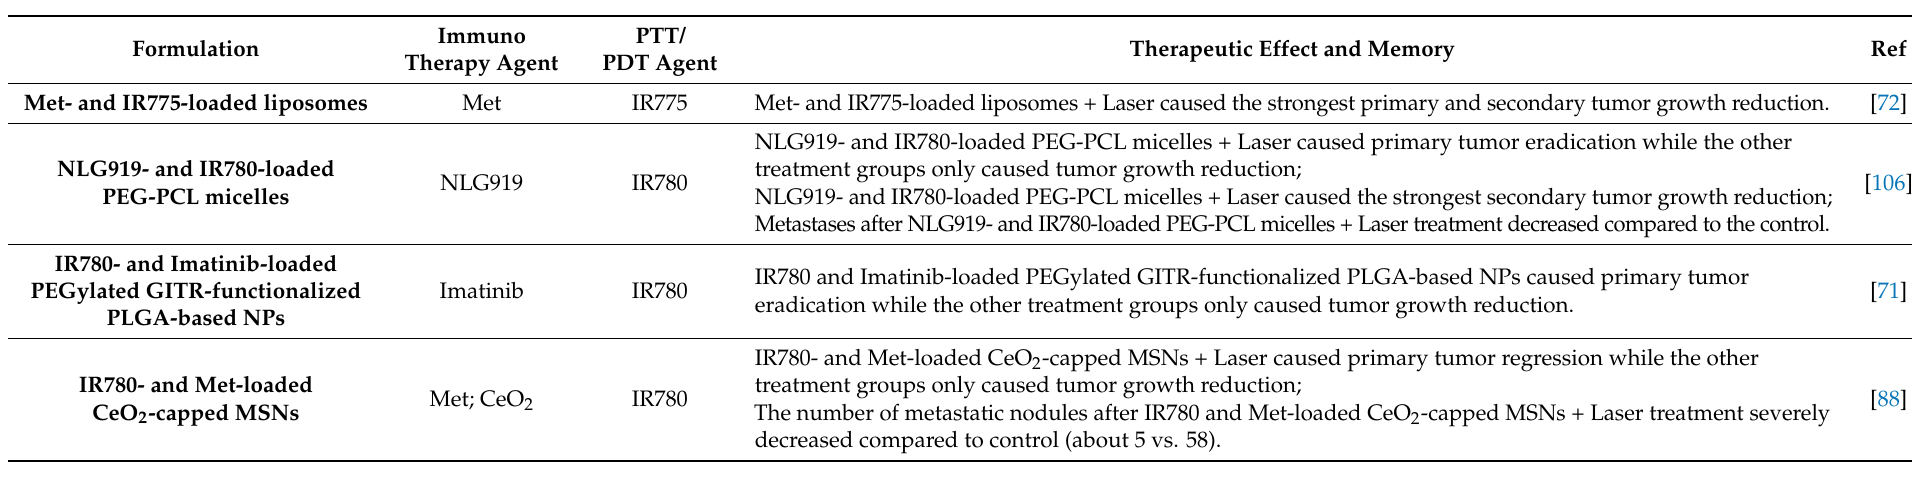
Table 4. Outcome generated by the immuno-PTT/PDT mediated by prototypic HC-based nanomaterials in the primary/secondary tumors and tumor